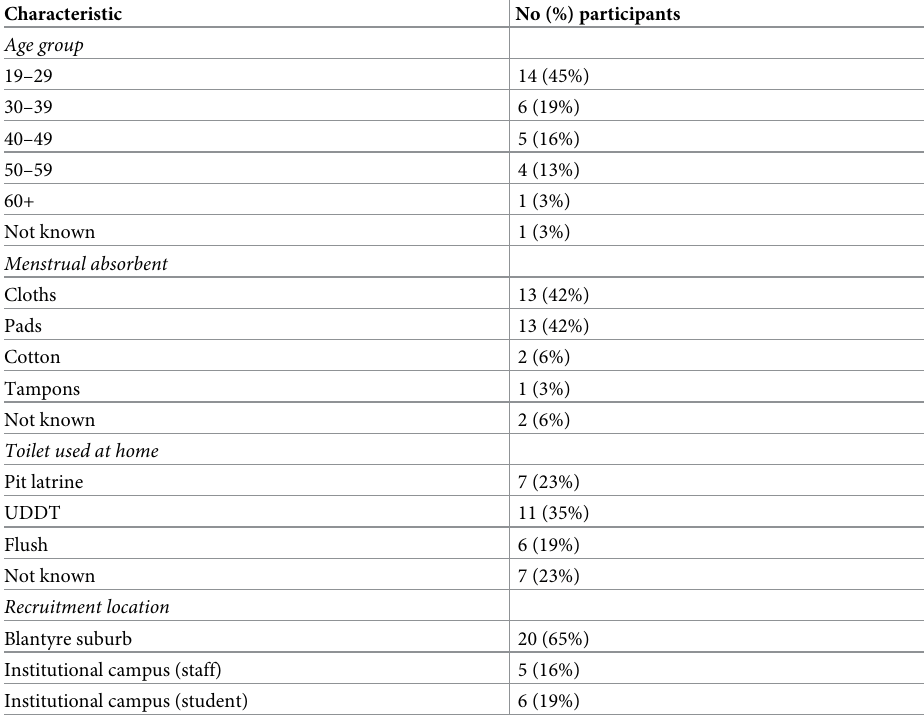
Table 1. Characteristics of